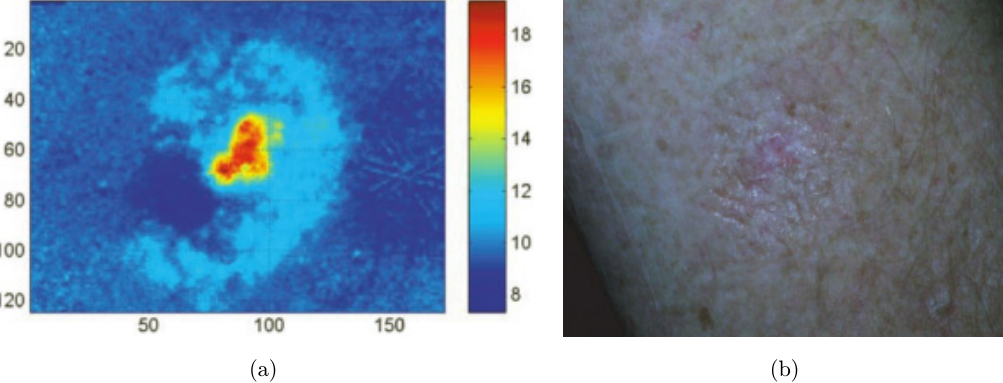
Fig. 1. (a) Fluorescence lifetime imaging of BBC of the skin, (b) skin color. 23 (Permission has been granted by \IOP Publishing" through Copyright Clearance Center's RightsLink r